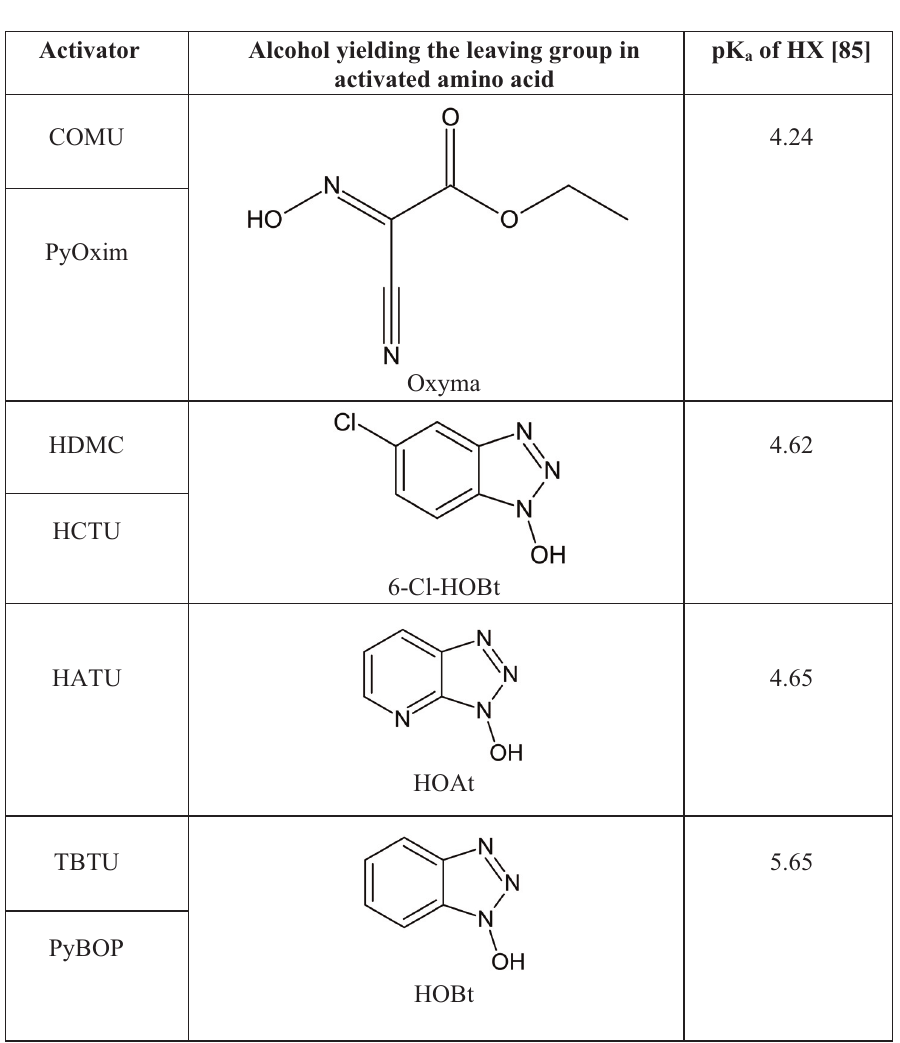
Table 2. Structures of alcohols corresponding to leaving groups X of activated amino acids